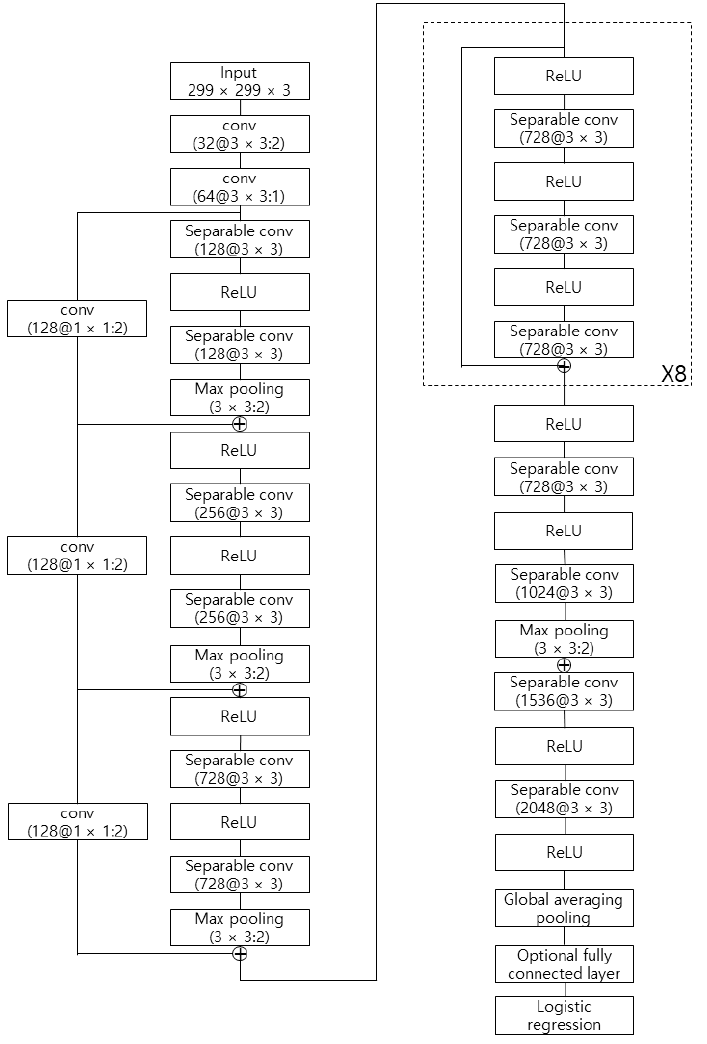
Figure 6. Structure of Xception.